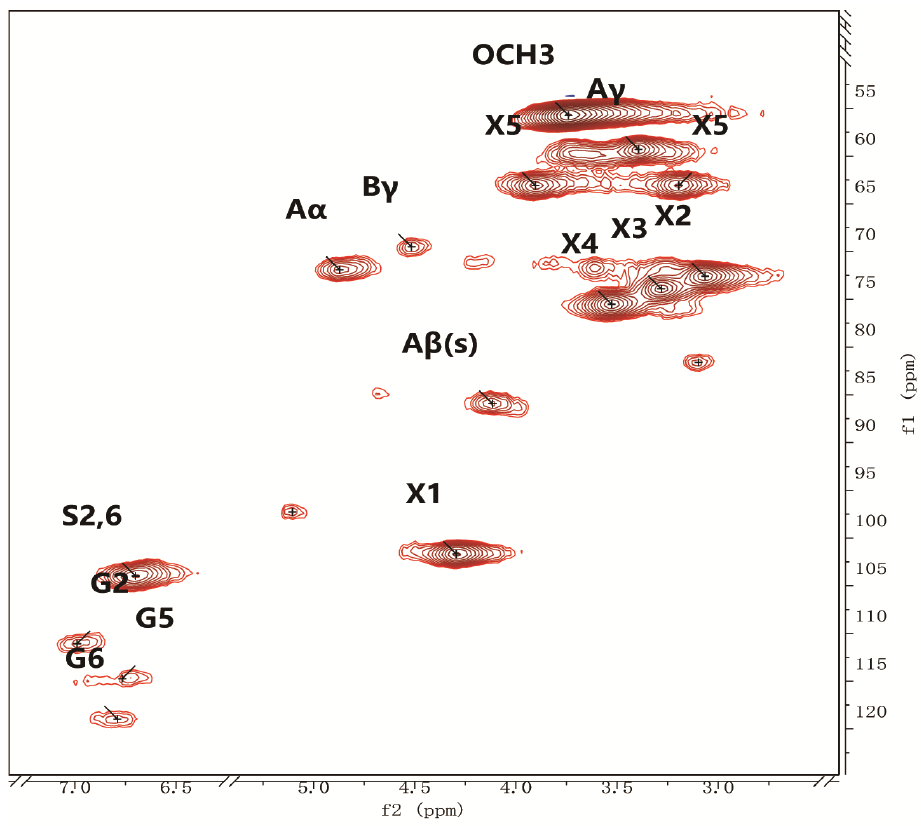
Figure 1. 2D HSQC NMR spectrum of BW-LCC.